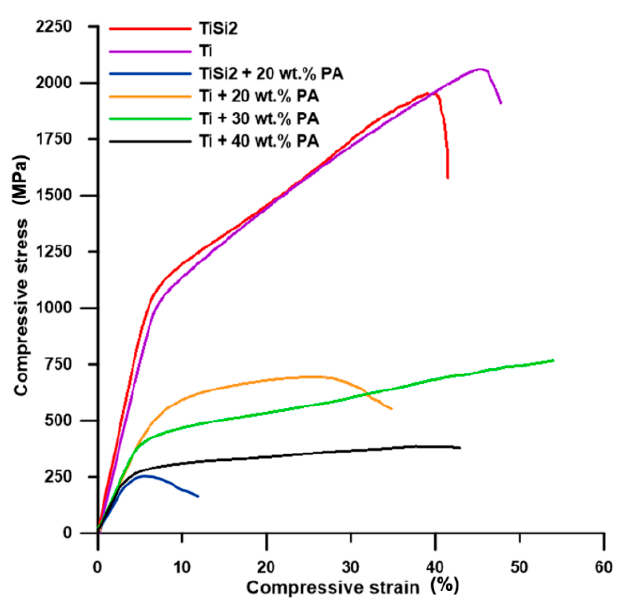
Figure 7. Engineering compressive stress–strain curves.